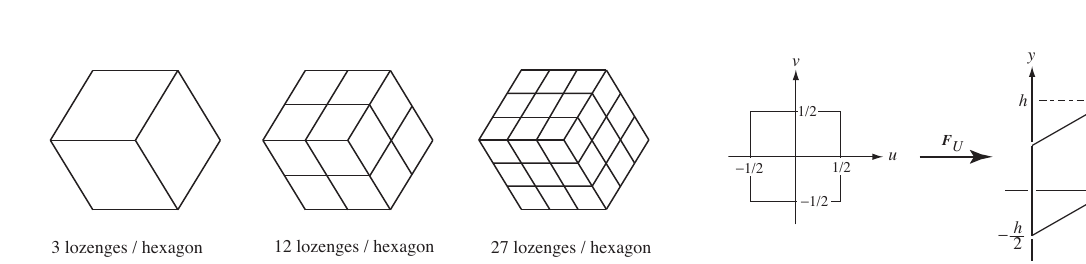
Figure 2: Affine transformation for one of the lozenges making up the